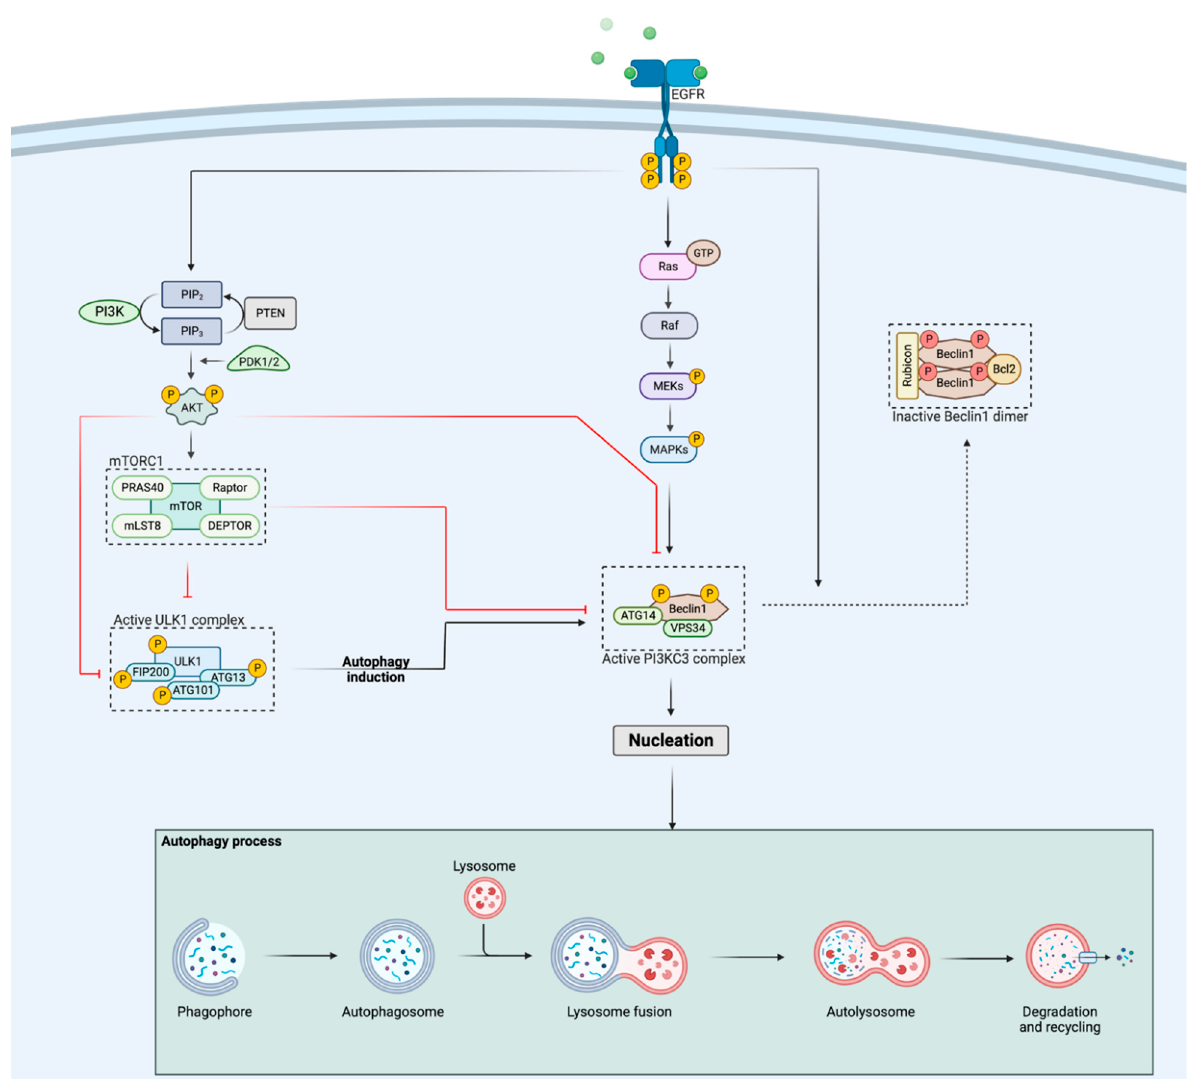
Figure 1. Schematic representation of the regulation of autophagy by the EGFR and PI3K/Akt pathways. Activation of EGFR stimulates the PI3K/Akt pathway, which in turn negatively regulates autophagy activation via different ways: (i) Akt and mTORC1 inhibit the PI3KC3 complex through phosphorylation and (ii) Akt and mTORC1 suppress the activity of the ULK1 complex, hereby preventing autophagy initiation. The Ras/Raf/MAPK pathway, activated by EGFR, positively regulates the autophagic response through phosphorylation of Beclin1, whereas activated EGFR itself negatively regulates autophagy by binding to Beclin1, followed by homodimerization of Beclin1 and the binding of two autophagy suppressors, Rubicon and Bcl2, rendering the complex inactive. When both the ULK1 and PI3KC3 complex are released from their inhibitory signals, nucleation will be initiated, leading to further expansion of the phagophore. The figure was created with BioRender.com (accessed on 23 October 2022).